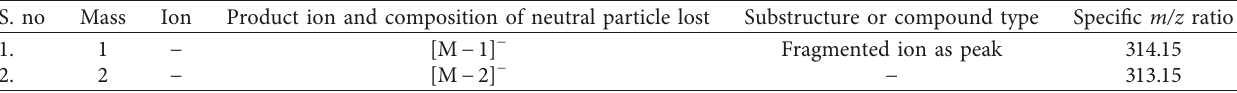
Table 5: Mass spectral interpretation of peak 3 from LC-MS-MS done on A. candolleanus root extract. S.